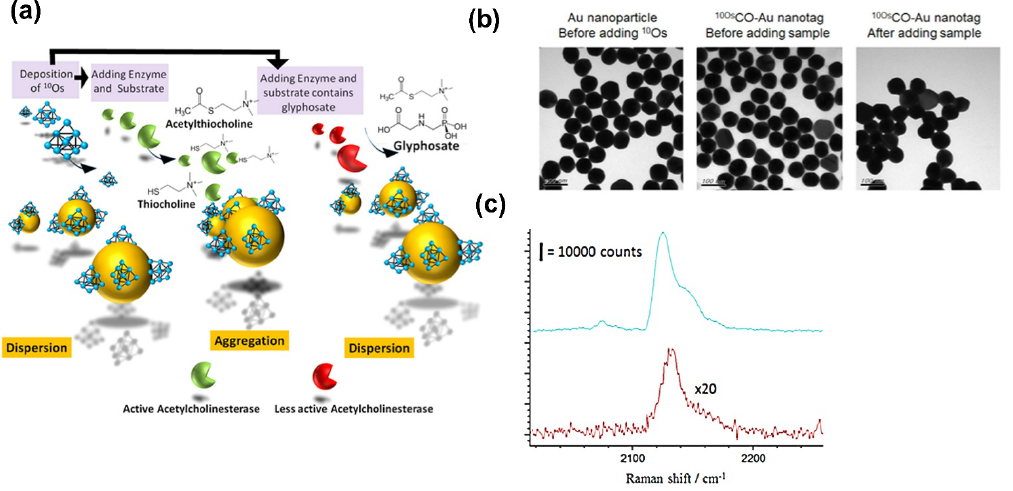
Figure 5. ( a ) Schematic representation of a GLYP sensor design strategy using 10Os CO-Au NPs as SERS probe. ( b ) TEM images of Au nanoparticles, 10Os CO-Au NPs and aggregated 10Os CO-Au NPs and ( c ) SERS spectra of 10Os CO-Au NPs scanned at 633 nm (top) and 532 nm (bottom). Reprinted/adapted with permission from [105]. Copyright 2017 Elsevier.